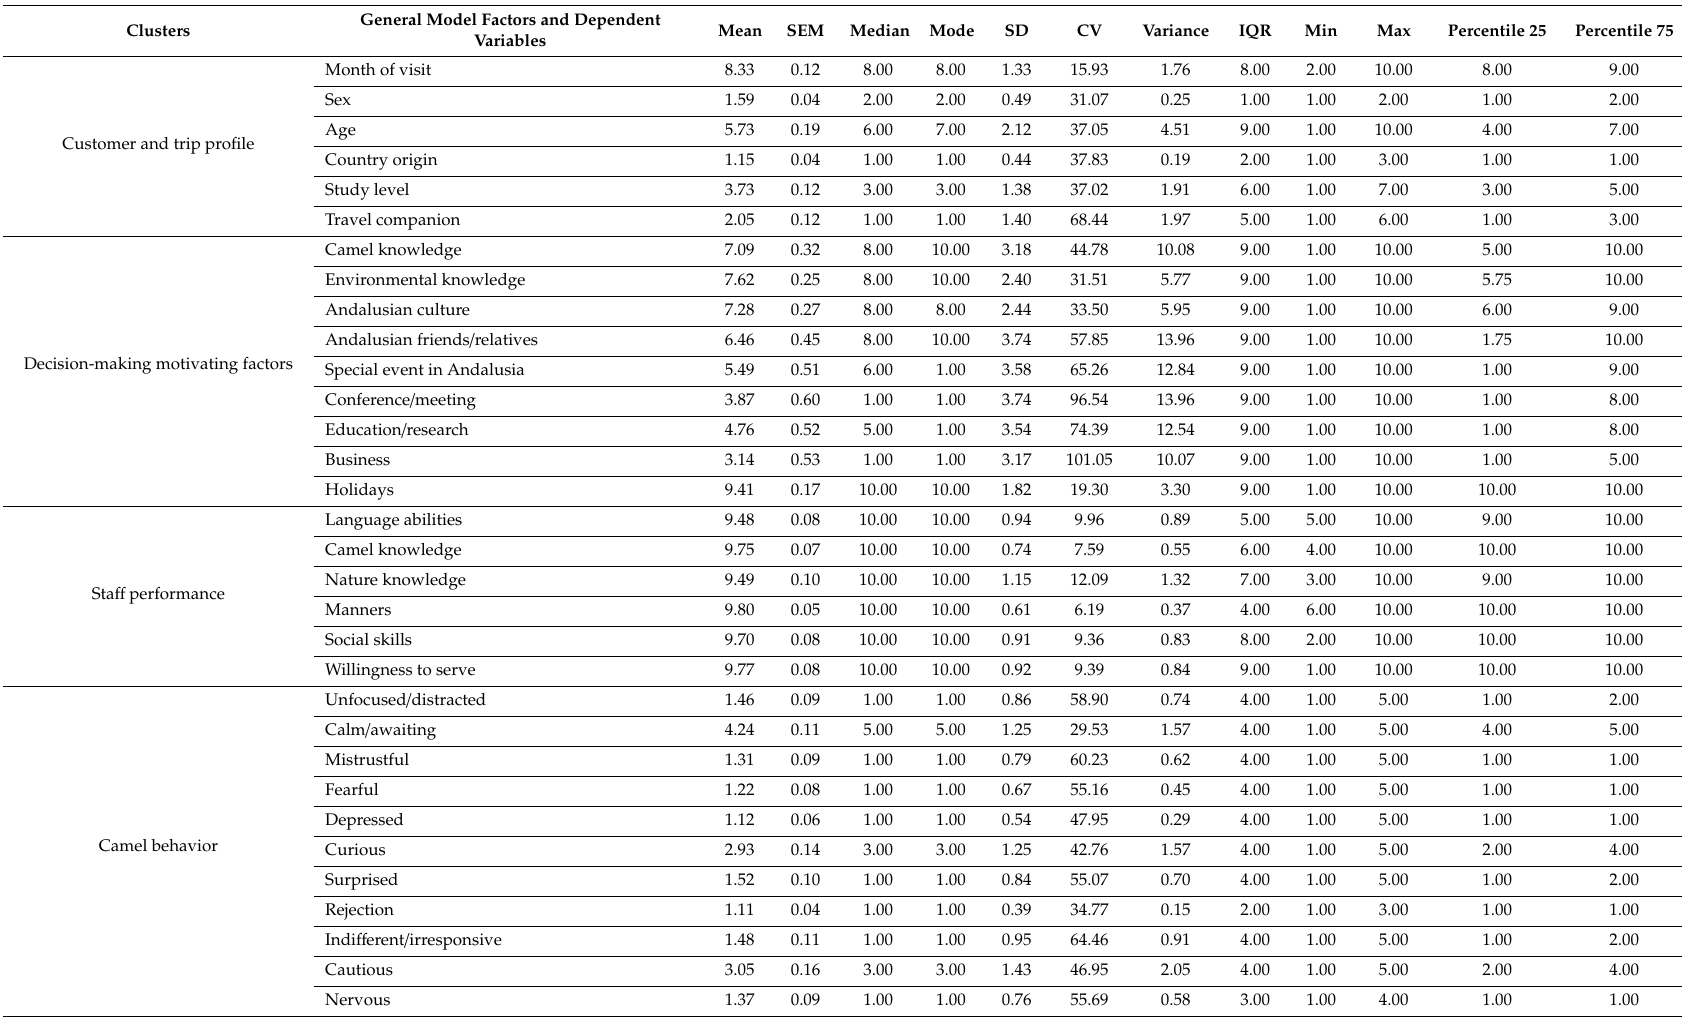
Table 2. Summary of descriptive statistics of factors and variables of customer’s general satisfaction and return intention probability in regards to camel tourist walks.